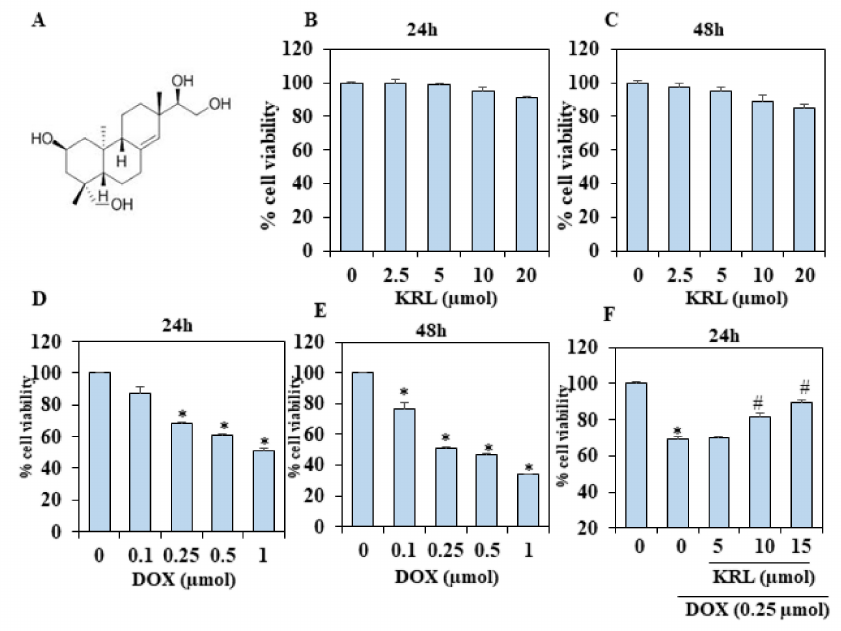
Figure 1. Kirenol (KRL)-attenuated DOX-induced cytotoxicity in H9c2 cardiac cells. ( A ) Chemical structure of kirenol. ( B , C ) Effect of KRL on the viability of H9c2 cardiomyocytes examined by an MTT assay. H9c2 cells were treated with increasing concentrations of KRL (2.5–20 µ mol) for 24 and 48 h, respectively. Cell viability (%) was measured as follows: (A570 of treated cells/A570 of untreated cells) × 100. ( D , E ) The cell viability with increasing concentrations of DOX (0.1–1 µ mol) for 24 and 48 h, respectively. ( F , G ) The effects of KRL along with DOX on the cell viability of H9c2 cells were determined by MTT assay. H9c2 cells were cultured in serum free media for 3 h followed by the treatment with KRL for 2 h before or after DOX treatment, respectively. Data are represented as the mean ± SD of triplicate values ( n = 3) and * p < 0.05 represents significant variations compared with the control. # p < 0.05 represents significant variations as compared to DOX alone and KRL with DOX treatment